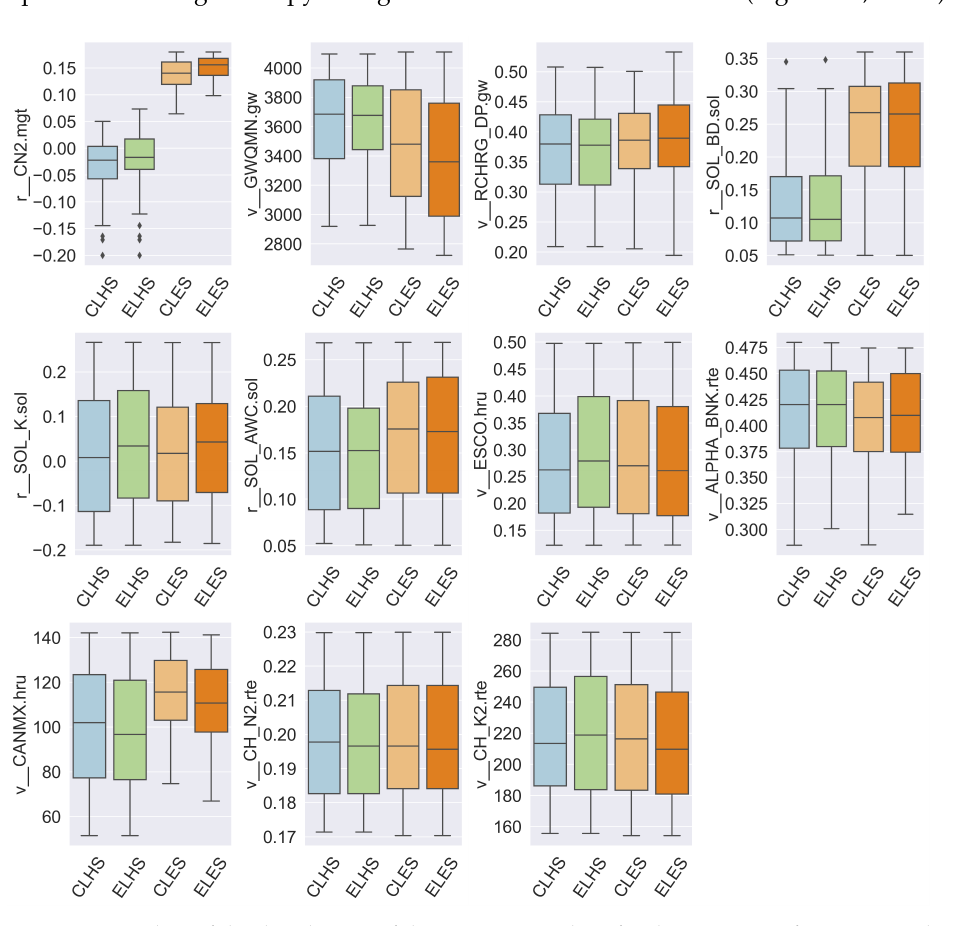
Figure 4. Boxplots of the distribution of the parameter values for the top 5% performing simulations during the joint uncertainty analysis for each of the selected 11 parameters of the common parameter list. The parameter descriptions and units are listed in Table